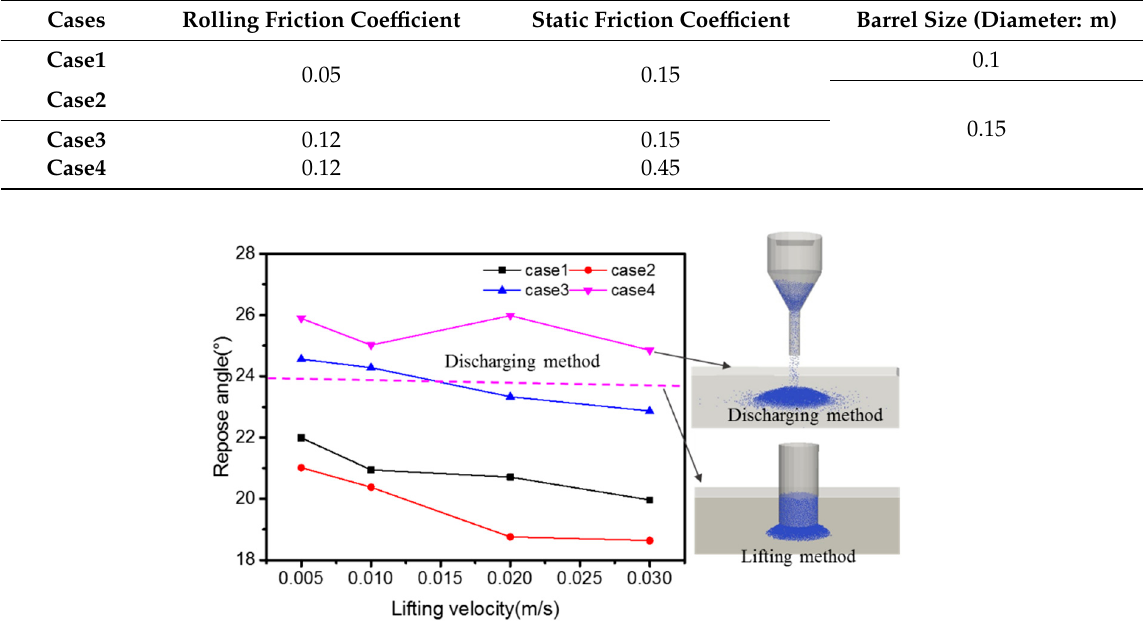
Figure 7. The angle of repose for different lifting velocities. Pink dotted and solid lines represent the angle of repose with different packing methods, but the same DEM parameters. Table 3. Different cases studied by the Lifting Method.